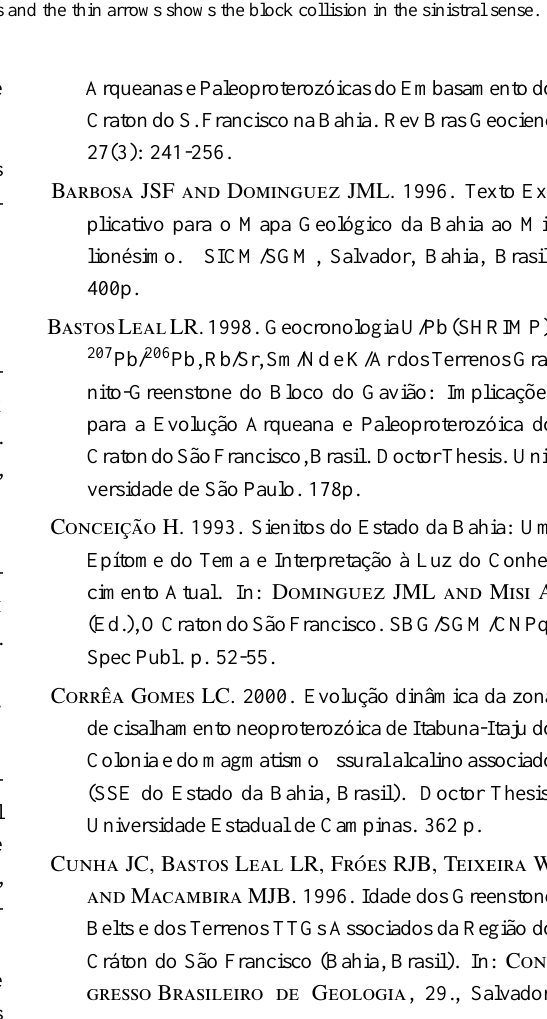
Fig. 8 – Summary of the main evolutive stepsArchean and Paleoproterozoic of the São Francisco Craton basement in Bahia. The thick arrows with the simbols shows the main intrusive plutonic rocks and the thin arrows shows the block collision in the sinistral sense.